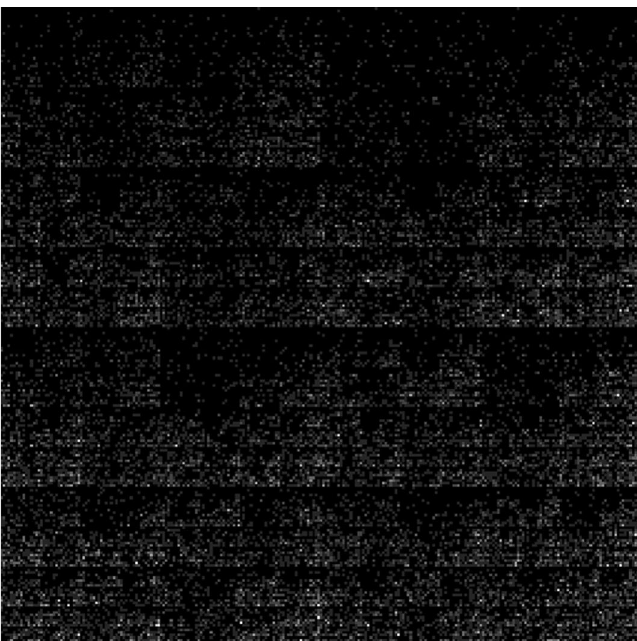
Figure 3. Eighth-order FCGR image for a COVID-19 sequence.